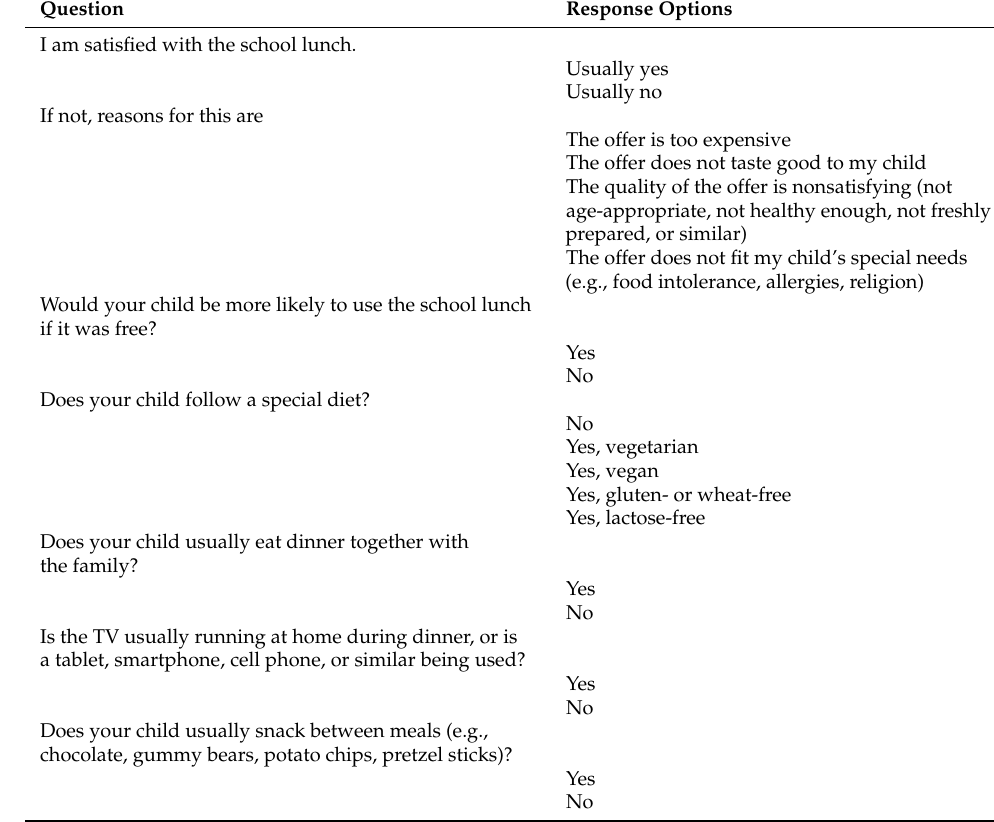
Table 2. List of items regarding “eating behavior” (parent